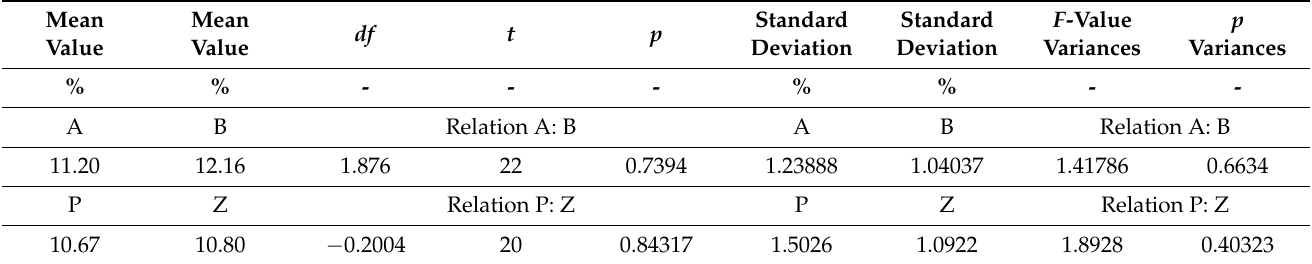
Table 5. Statistical analysis of moisture content in tested pine beams.